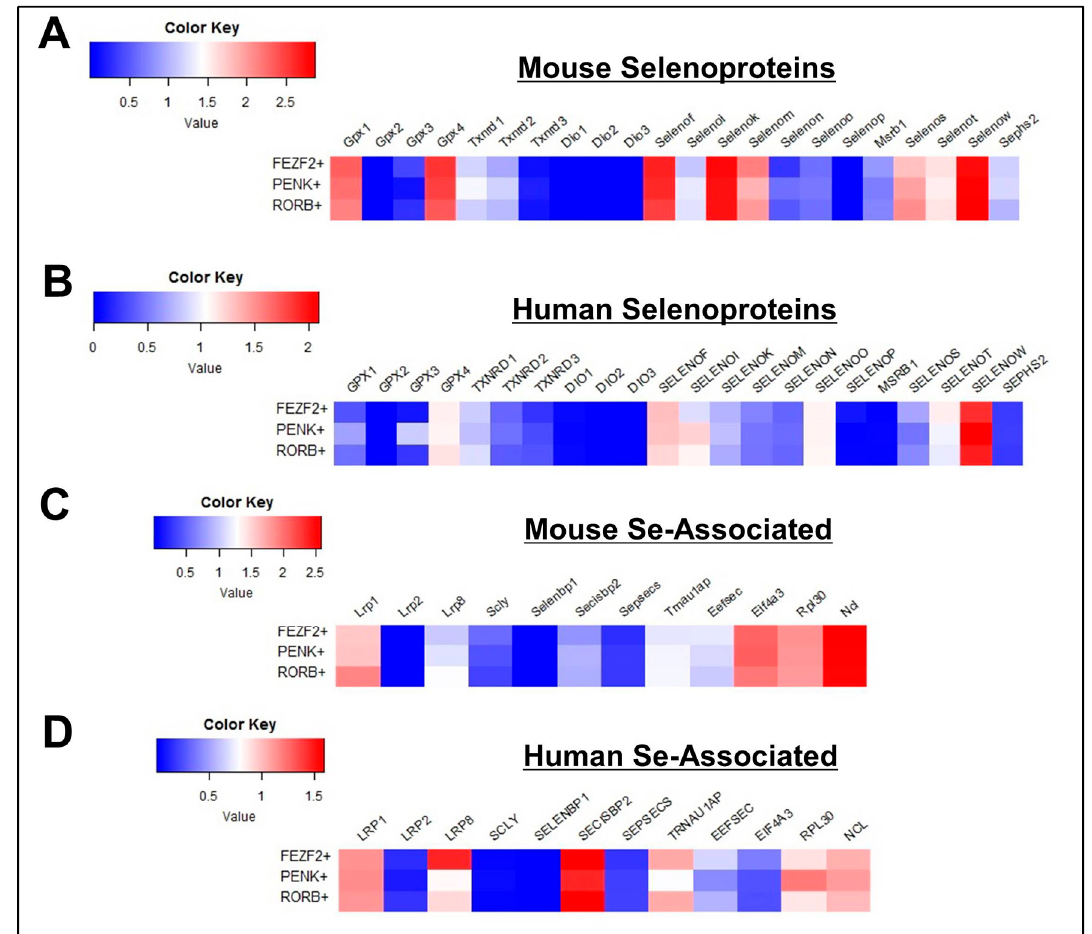
Figure 5. Profile of Se-Related Transcriptome in Glutamatergic Neurons. ( A , B ) Heatmaps detailing expression of mouse ( A ) and human ( B ) selenoprotein genes in FEZF2 + , PENK + , and RORB + glutamatergic neurons. ( C , D ) Corresponding heatmaps of mouse ( C ) and human ( D ) Se-associated genes.